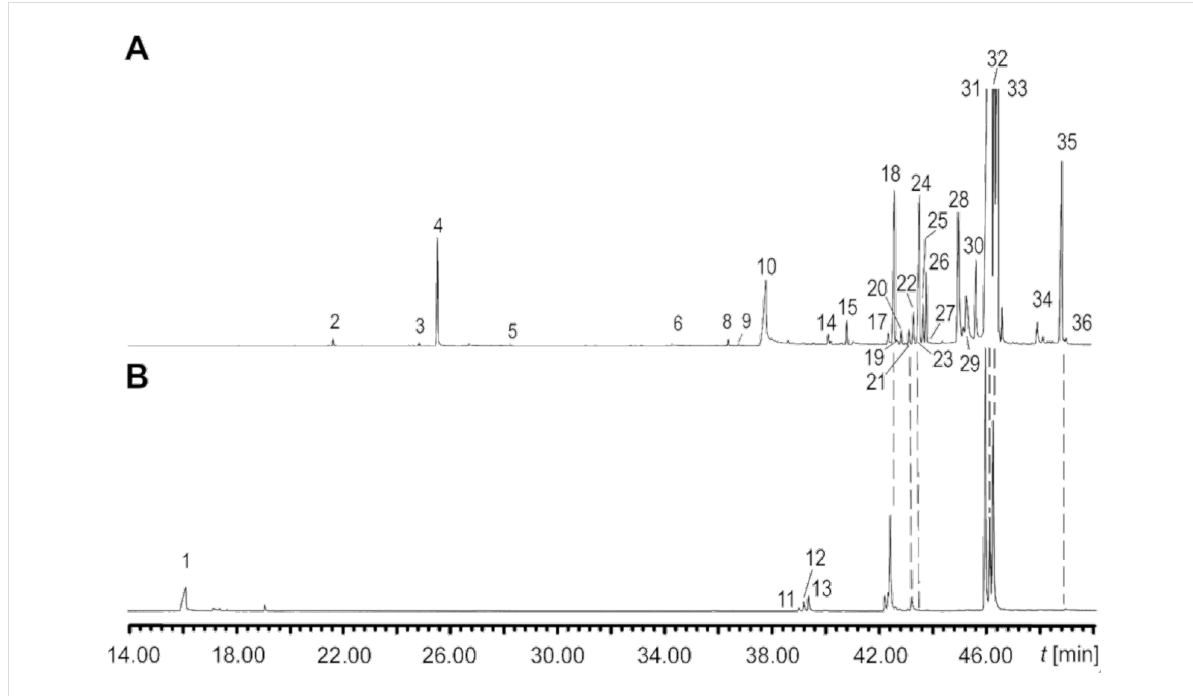
Figure 2: Total ion current chromatogram of androconial extracts of male butterflies of the two subspecies I. salapia derasa (A) and I. s. aquinia (B). The numbers refer to the entry numbers in Table 1.